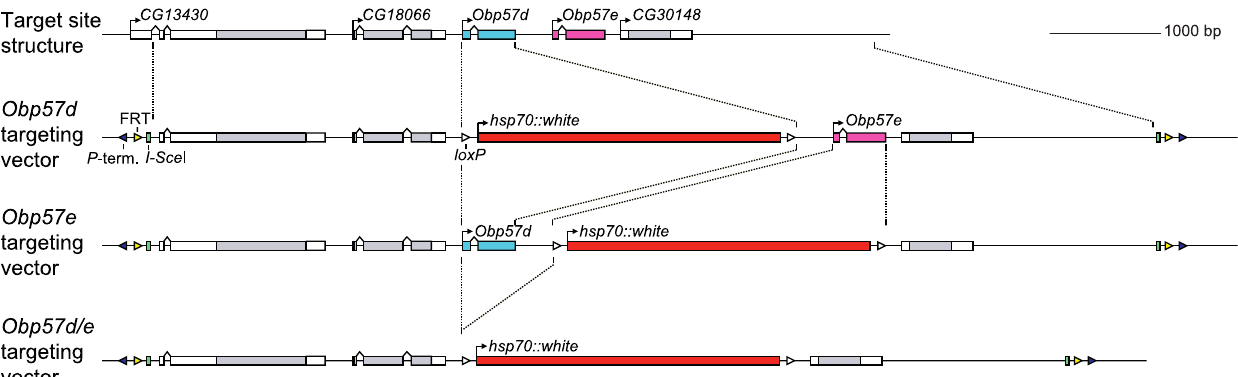
Figure 4. Generation of Obp57d/e Knock-Out Flies by Gene Targeting (A) Targeted gene replacement by the ends-out method. A donor transgene integrated into the other chromosome by P element–based transformation was excised by the FLP recombination enzyme at FLP recognition target (FRT) sites. Resulting circular DNA was linearized by I-SceI, inducing a precise replacement of a target gene with a marker gene. Finally, a marker gene was excised by Cre recombinase that recognizes loxP sequences, leaving a single 34-bp loxP sequence. (B) Vector structures for Obp57d/e -targeted mutagenesis. doi:10.1371/journal.pbio.0050118.g004 PLoS Biology |